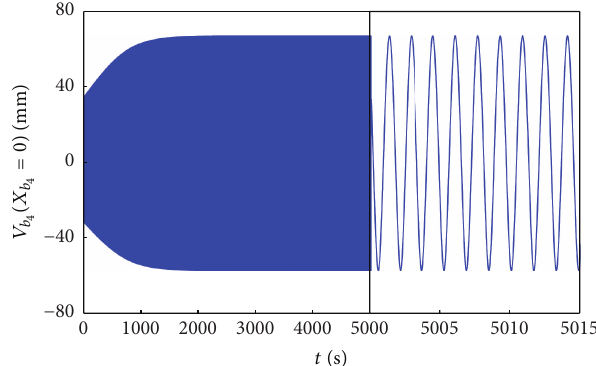
Figure 16: Time response of the midpoint of the deck beam, 𝑞 1 (0) = 0.1 and 𝑁 = 1 .